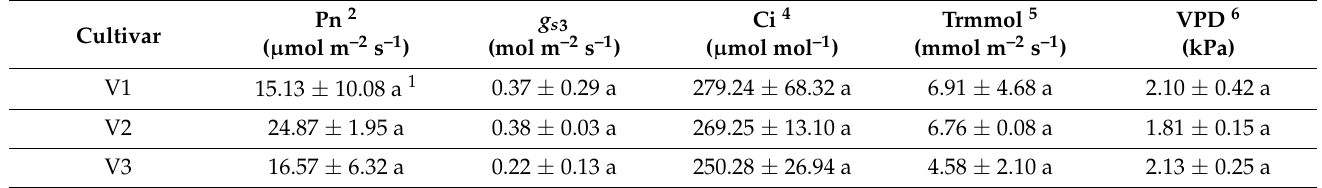
Table 4. Photosynthetic activities of three danshen cultivars grown in Mississippi, United States in